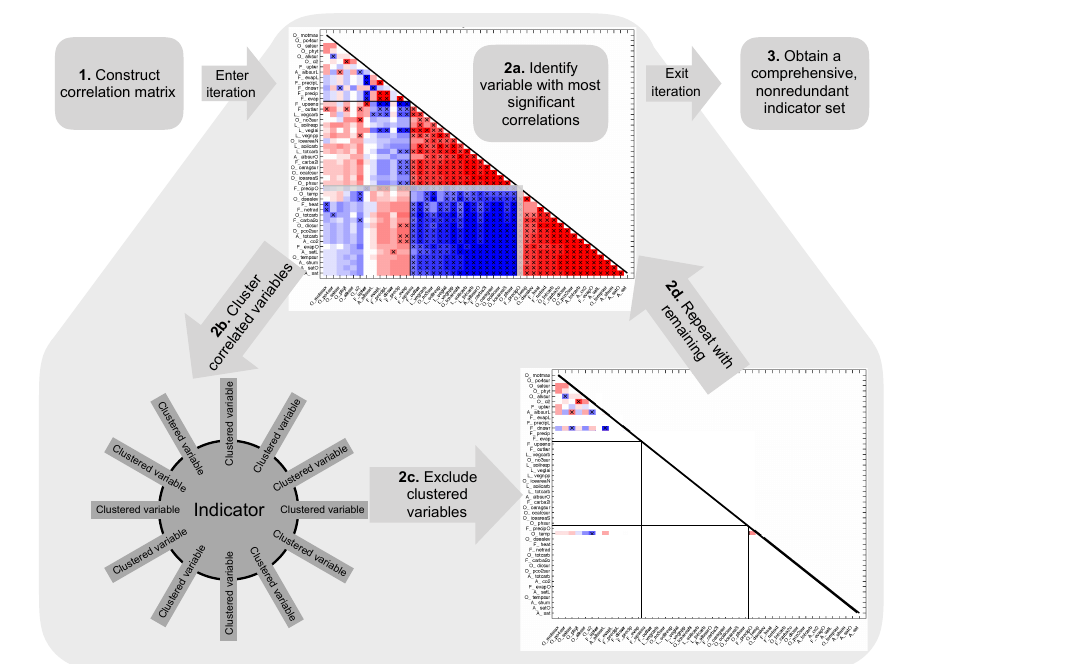
Figure 2. Illustration of the indicator selection process using the example of the correlation matrix for the historical scenario (see Fig. 3 for a more detailed display of the correlation matrix). The correlation matrix, was constructed as explained in Fig. 1 but for the temporal differences between 1850–1860 and 1995–2005. See Sect. 3.2 for a detailed step-by-step description of the evaluation process. Prefixes A, O, L, and F stand for atmosphere, ocean, land, and fluxes, respectively; for a detailed description of the model output variables, see Table